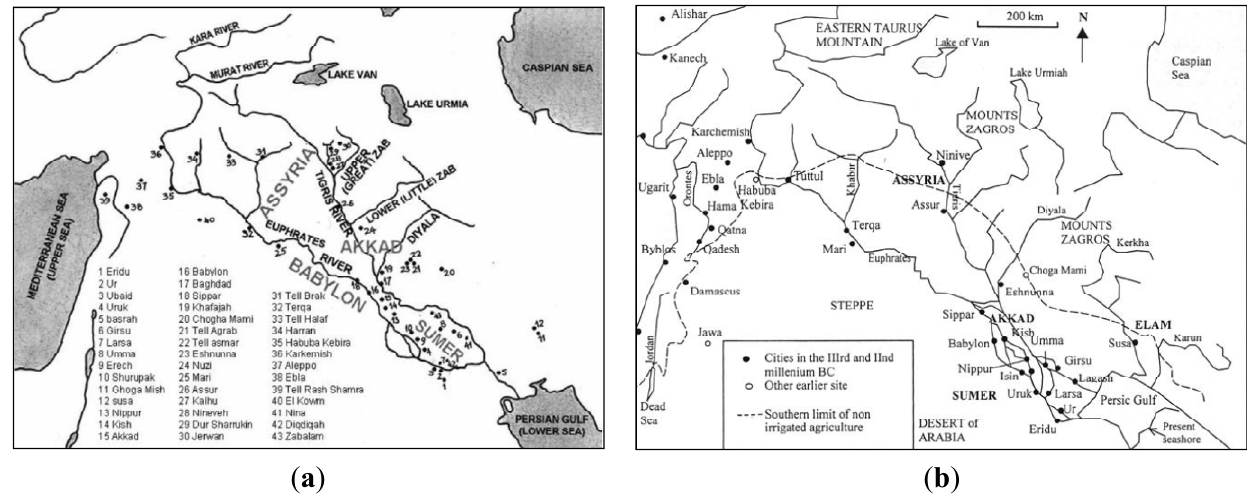
Figure 1. Major urban areas in Greater Mesopotamia: ( a ) General view [3]; and ( b ) Tigris and Euphrates Rivers with the major cities during Bronze Age